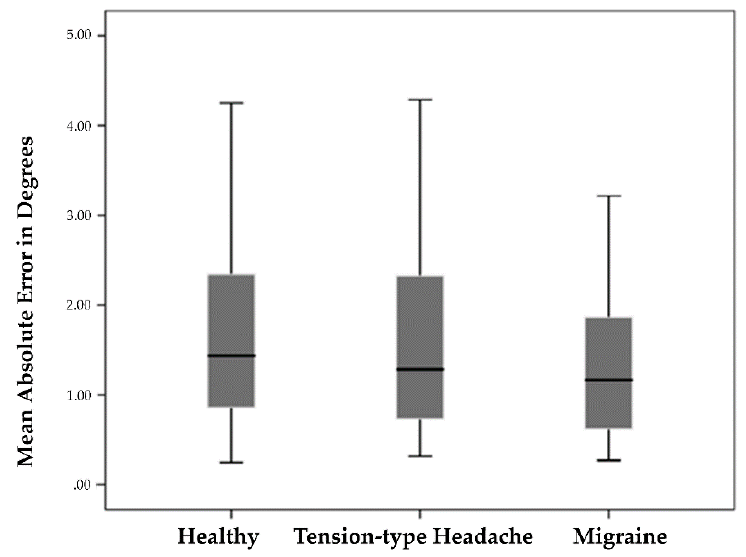
Figure 3. Between-group differences in mean absolute error in estimating subjective visual vertical (SVV).